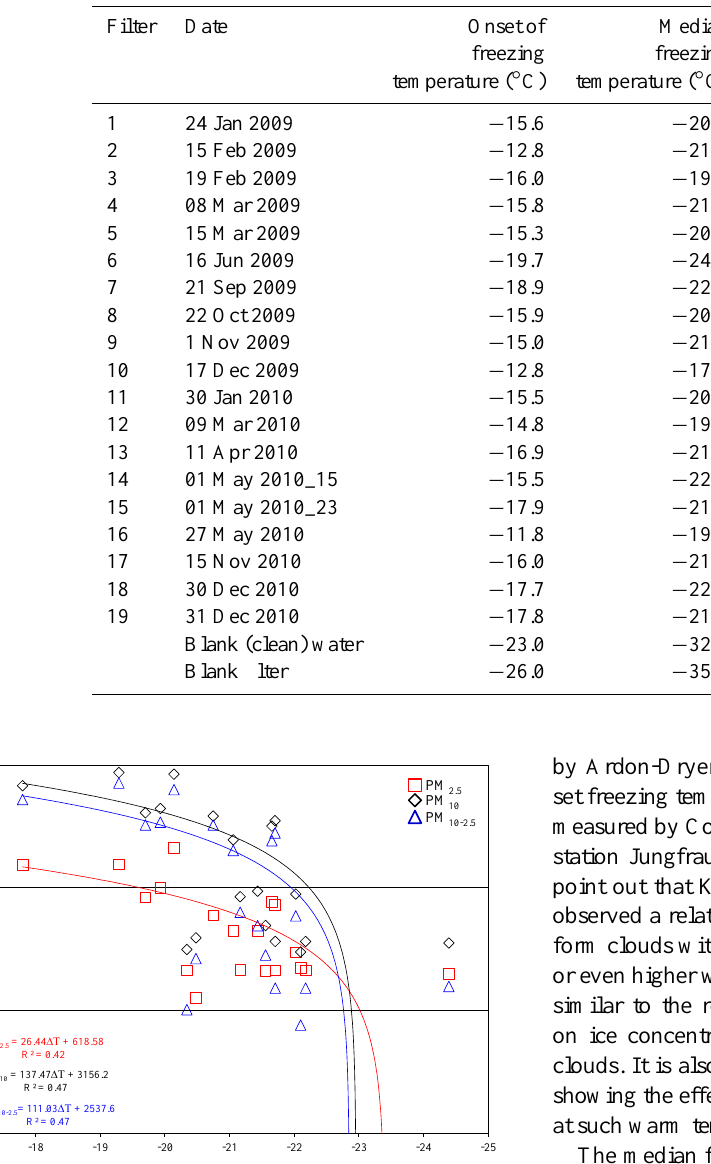
Table 2. Results of the onset of freezing temperature, median temperature and the temperature of the last freezing drop in each sample. List of the freezing spectra of all measured filters and the average spectrum of freezing temperature from clean (blank) filters and blank (pure) water.